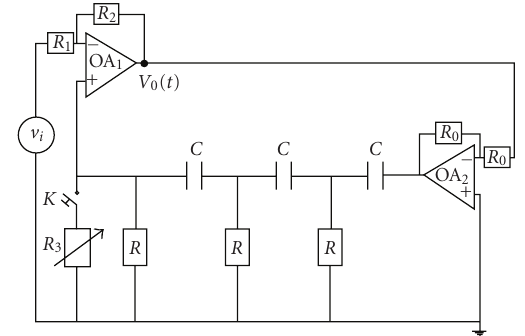
Figure 1: The phase shift